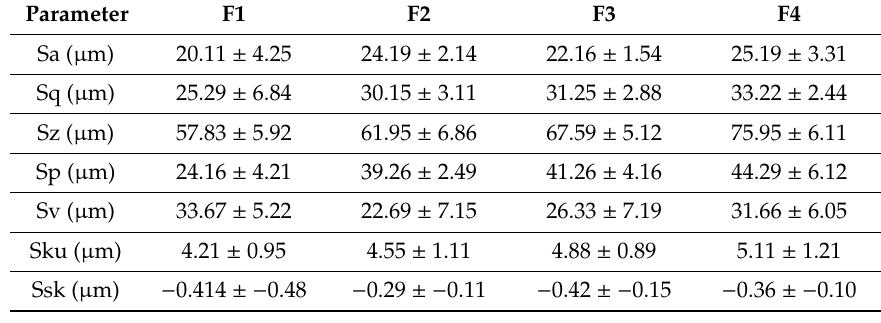
Figure 5. Surface texture images of 3D printed captopril tablets: ( a ) F1, ( b ) F2, ( c ) F3, and ( d ) F4. Table 3. 3D parametric surface texture analysis of 3D printed captopril tablets (n = 3).